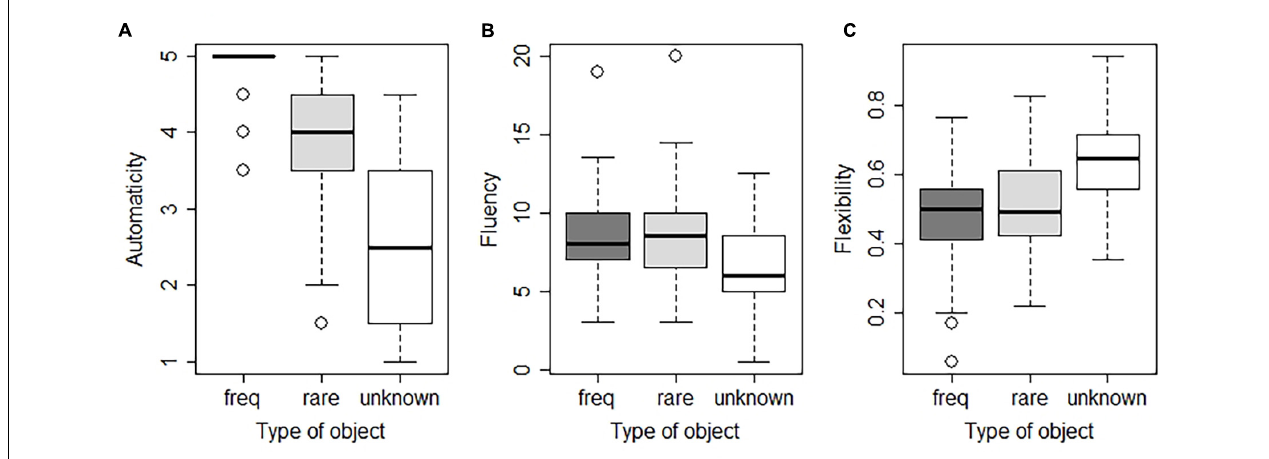
FIGURE 3 | Automaticity, fluency, and flexibility of responses generated for the AUT. (A) Self-reported automaticity (range: 1–5) for frequent (freq; in dark gray), rare (rare, in gray) and unknown (unknown, in white) in Task I. (B) Number of ideas generated (fluency; range: 0–20). (C) Number of categories cited (flexibility; ratio range: 0–1). Box plots display the median, lower, and upper quartiles, with whiskers representing values within 1.5 times the interquartile range. The individual dots represent